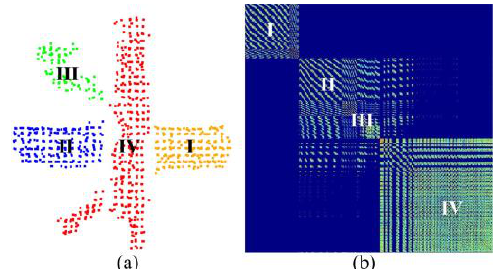
Figure 14. Subspace clustering result in one support region. (a) Subspace clusters. (b) Reordered similarity